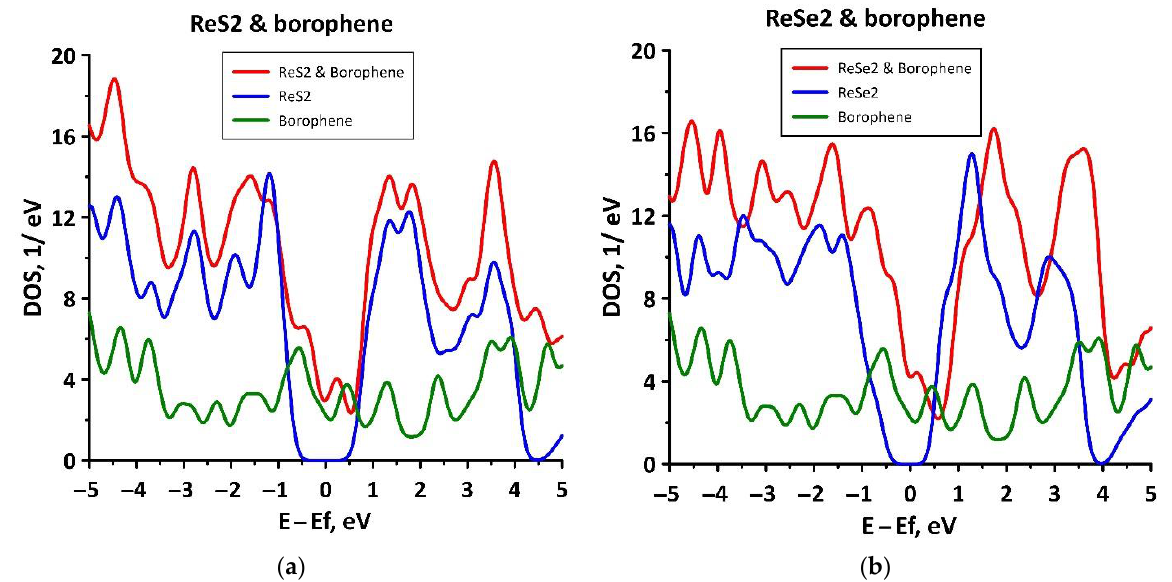
Figure 4. DOS of borophene/ReS 2 ( a ) and borophene/ReSe 2 ( b ) van der Waals heterostructures.